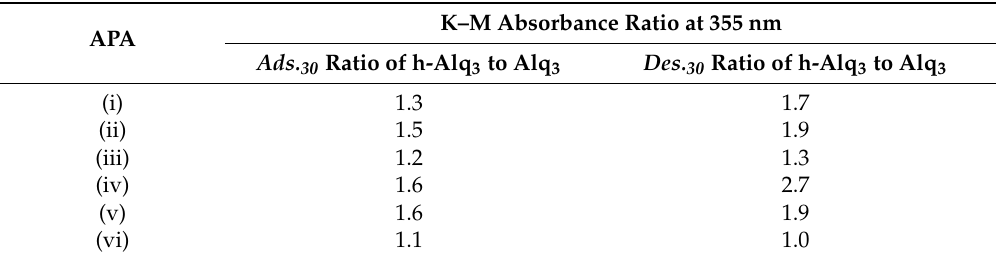
Table 4. Ads. 30 and Des. 30 ratios of h-Alq 3 to Alq 3 obtained for various APA surfaces.